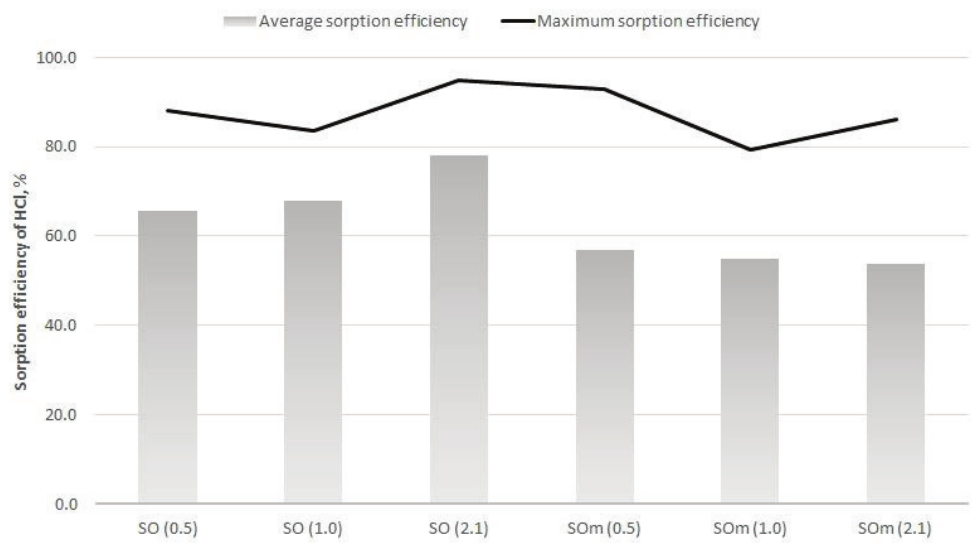
The average HCl removal efficiency was above 50 %. When using the SO reagents, the average efficiency was from 66 % to 78 %, and when using SOm it was in the range of 54 – 57 %. The maximum efficiency was at the level of 79 – 95 %. The Fig. 15 – Average and maximum sorption efficiency of SO after the application of sodium compounds 2 values of the average and the maximum HCl removal efficiencies are presented in Fig. 16. in various molar ratios Fig. 15 Average and maximum sorption efficiency of SO 2 after the application of sodium compounds in various molar ratios